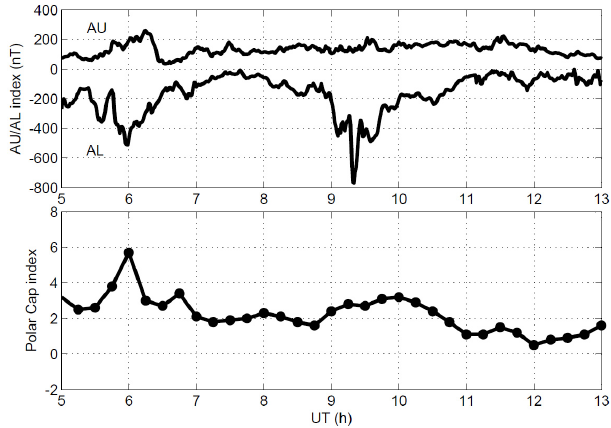
Fig. 1. AU/AL indices from WDC for Geomagnetism, Kyoto Figure 1. AU/AL indices from WDC for Geomagnetism, Kyoto (top panel) and (top panel) and Polar Cap index from WDC for Geomagnetism, Polar Cap index from WDC for Geomagnetism, Copenhagen (bottom panel) during Copenhagen (bottom panel) in the interval of 05:00–13:00UT on 13 February the interval 0500-1300 UT on February 13 2001.